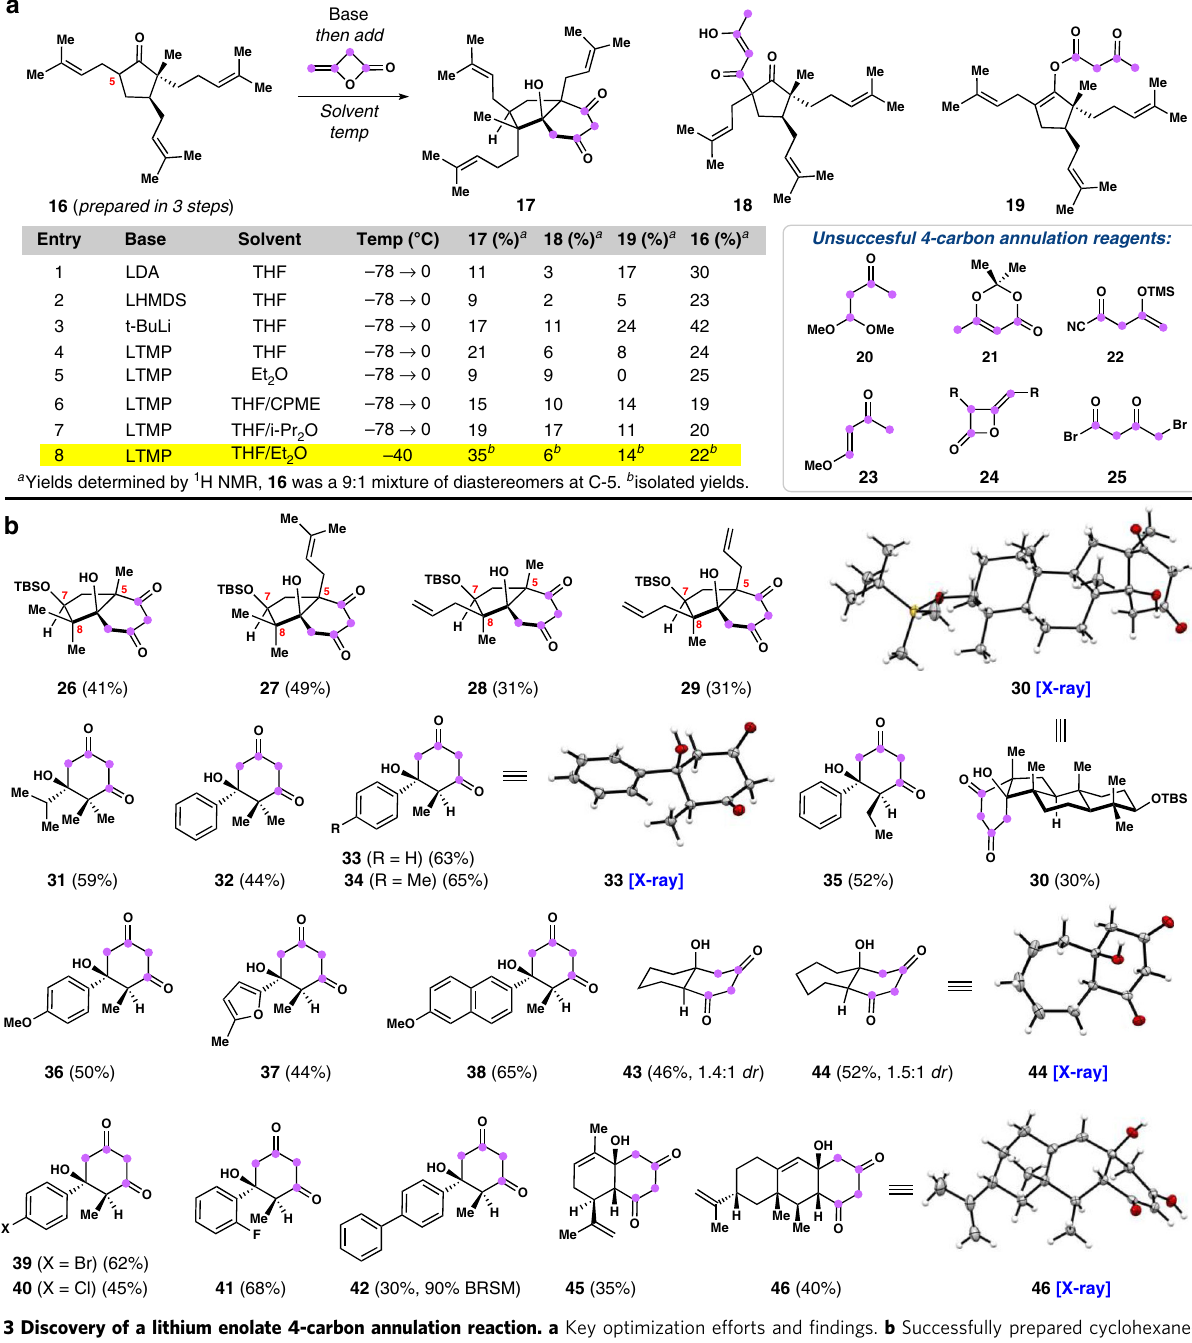
Fig. 3 Discovery of a lithium enolate 4-carbon annulation reaction. a Key optimization efforts and fi ndings. b Successfully prepared cyclohexane-1,3-